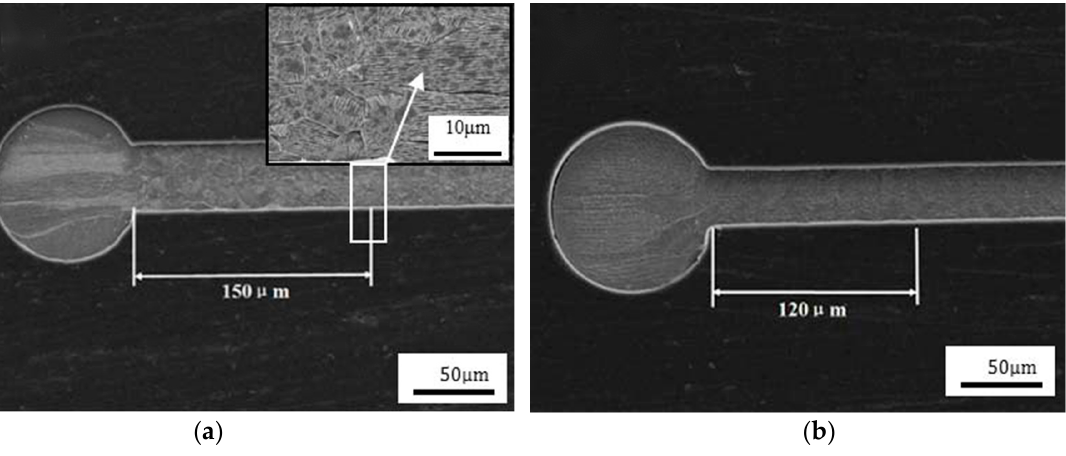
Figure 13. HAZ length of Ag alloy wire ( a ) Ag-1.7Pd wire; ( b ) Ag-1.7Pd-0.75Zn wire [155]. Repro- duced with permission from Jun Cao et al.; published by IEEE, 2015.